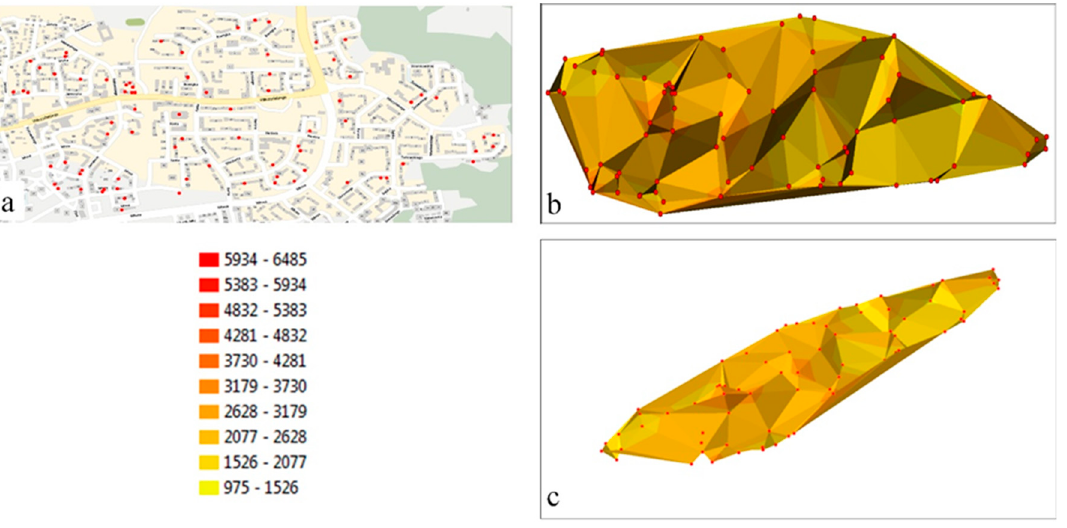
Figure 1. Triangulated irregular network (TIN) surface generated directly based on measurement points: ( a ) distribution of measurement points; ( b ) TIN surface visualized in 2D; ( c ) TIN surface visualized in 3D. Source: own elaboration.